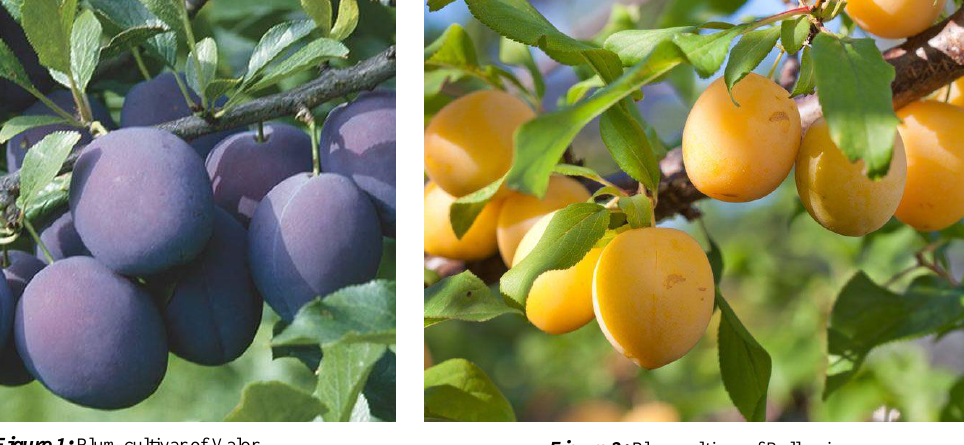
Figure 1: Plum cultivar of Valor Figure 2: Plum cultivar of Bellamira